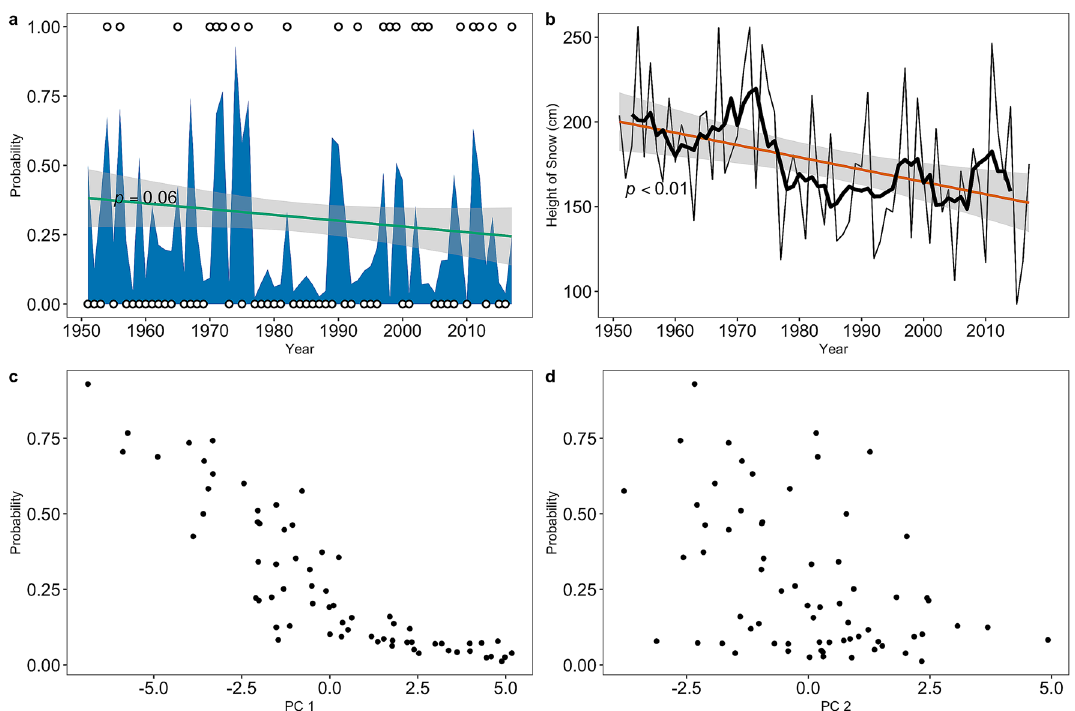
Figure 5. Regional avalanche probability and the major contributing variables. ( a ) Probability of an avalanche year in blue (white circles; 1 = observed avalanche year, 0 = observed non-avalanche year) using the generalized linear autoregressive moving average model. The green line represents a generalized linear model trend with 95% CIs shaded in gray. The p-value of 0.06 suggests a decreasing trend. ( b ) Time series of maximum snow depth (HS max ) (cm) (a major contributor to and function of the first principal component (PC1)) during the period of record. The red line represents a generalized linear model trend with 95% confidence intervals shaded in gray. The p-value of < 0.01suggests a decreasing trend. The black line denotes a 6-year moving average to the time series. ( c ) The probability of an avalanche year as a function of the values of PC1. ( d ) The probability of an avalanche year as a function of the values of the second principal component